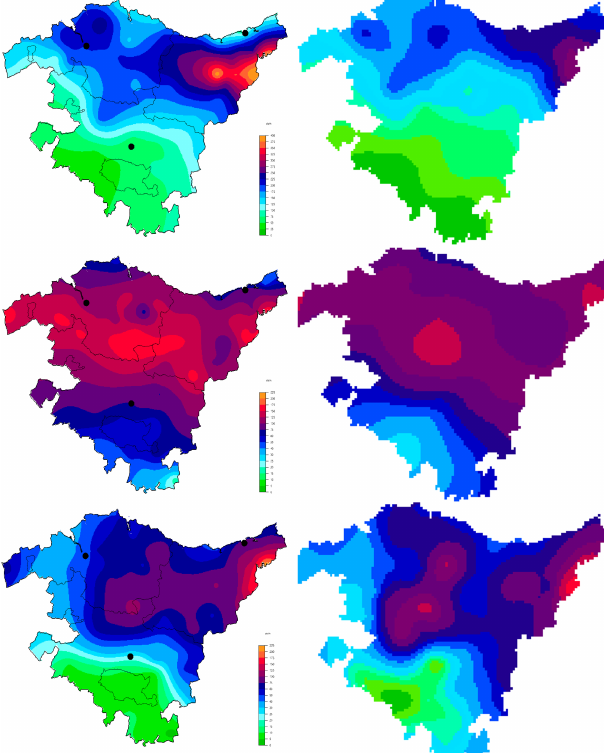
Figure 7. Examples of daily precipitation distribution maps (mm), observed (left panels) and simulated (right panels) for E0 7 Novem- ber 2001, E9 31 January 2015 and E6 26 February 2015 (from top to bottom